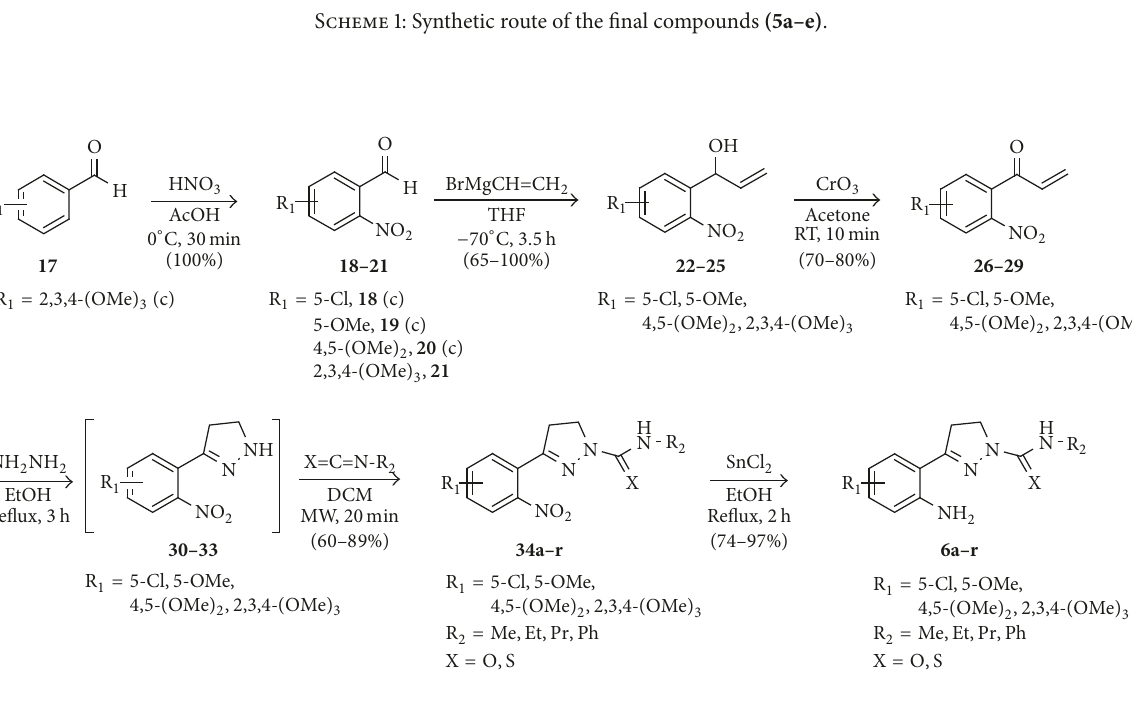
Scheme 2: Synthetic pathway of the final compounds (6a–r)